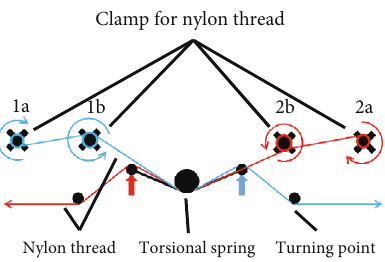
Figure 8: Diagram of the pretension mechanism and fi xation of nylon threads mounted on the slider.